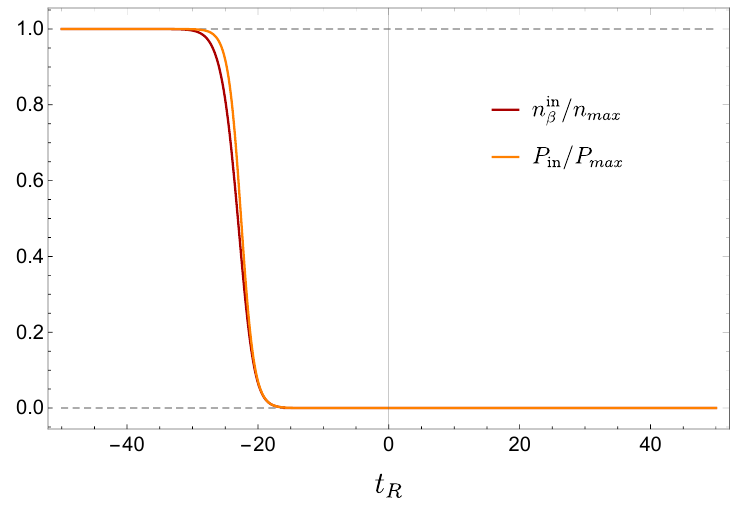
Figure 10 . Comparison of the “interior” size of ψ 1 ( t ) and the interior momentum as computed in JT gravity. Parameter values are the same as in figure